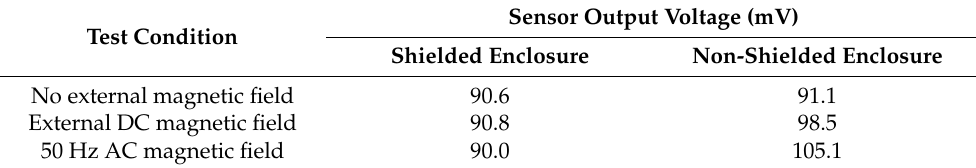
Table 2. Comparison of Shielding Effect under Different Interference.